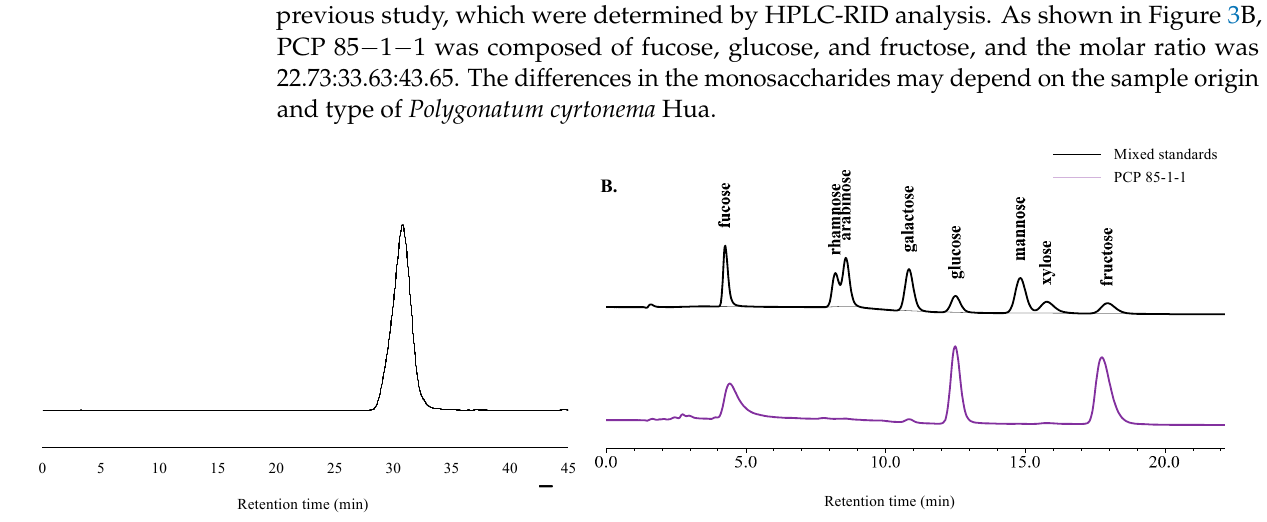
Figure 2. ( A ) Stepwise elution curve of crude PCP 85 on DEAE-Sepharose Fast Flow cellulose col-